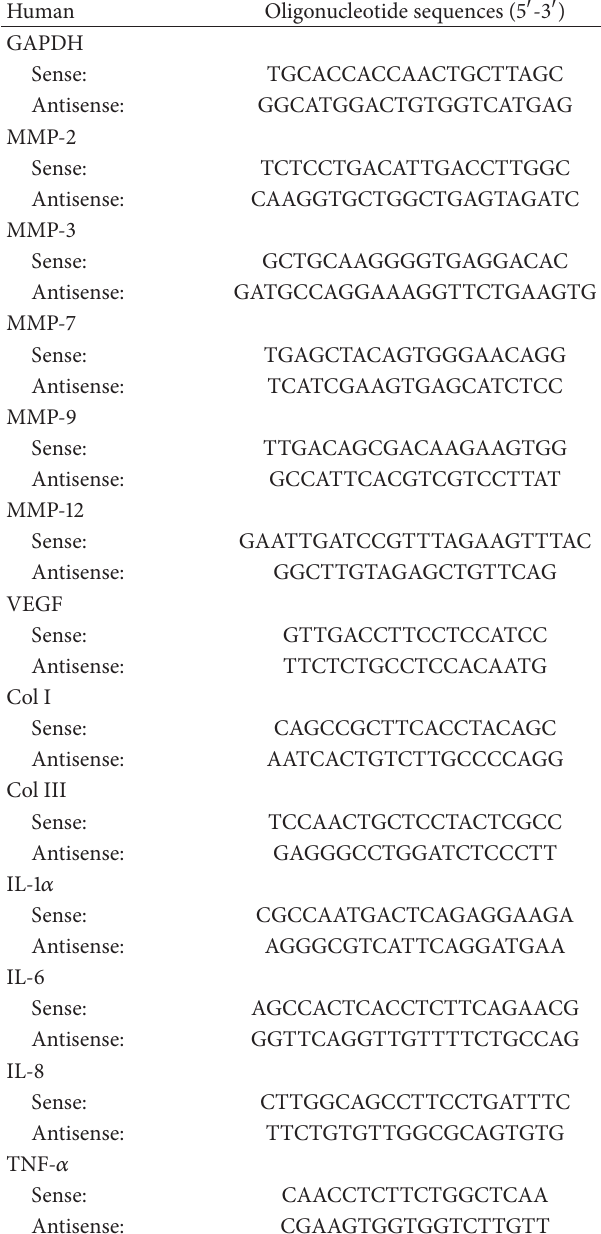
Table 1: Primers used for the real time reverse transcriptase-PCR analysis.